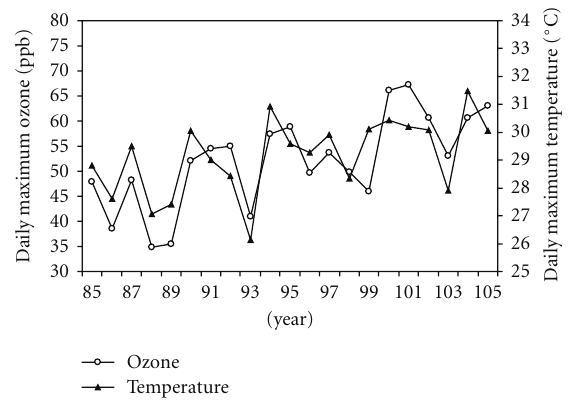
Figure 3: Long-term changes in daily maximum ozone concentra- tions in the Tokyo area and daily maximum temperatures at Nerima in the summer (source: National Institute for Environmental Studies and the Japan Meteorology Agency—JMA, Japan). The summer season is defined here as the average value of the summer months, that is, June, July, and August (according to the definition of the